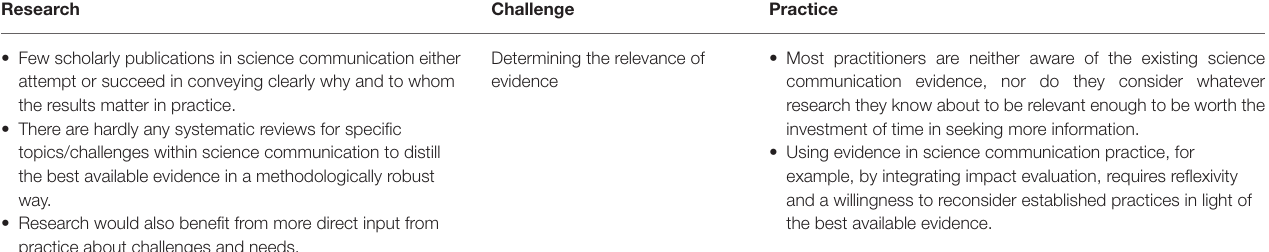
TABLE 1 | The science communication knowledge cascade: key challenges at the interfaces between research and practice.